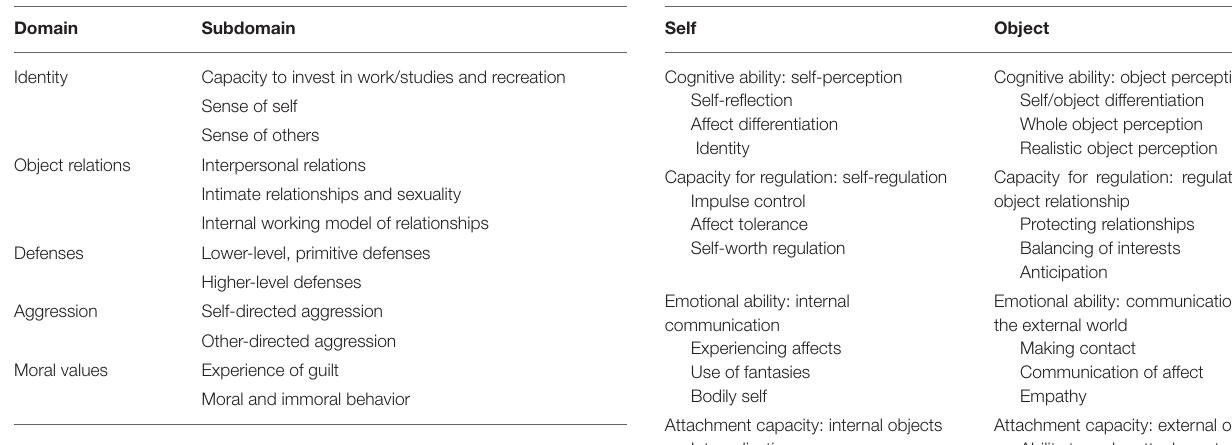
TABLE 2 | STIPO-R domains and subdomains. TABLE 3 | OPD-2 structural domains and